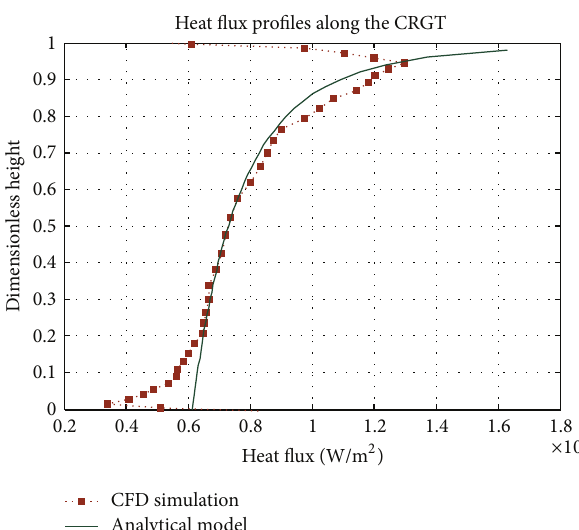
Figure 6: Heat flux profiles along the CRGT wall (CFD versus analytical